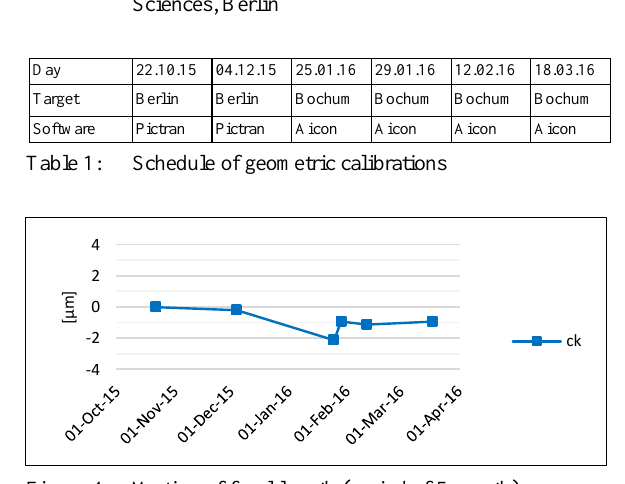
Figure 4: Motion of focal length (period of 5